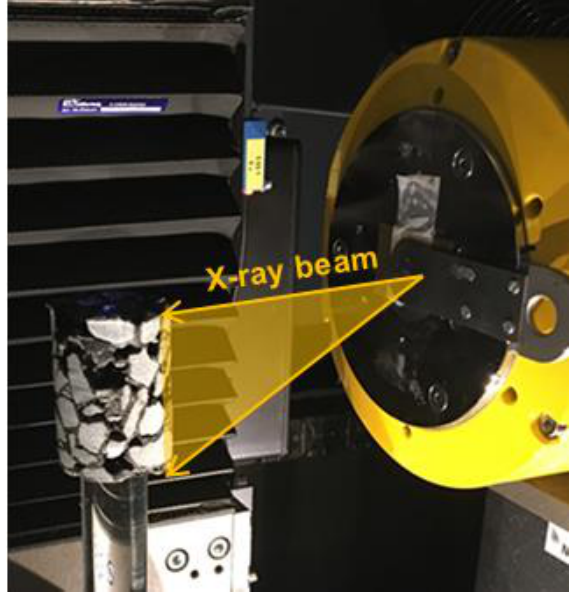
Figure 4. XCT scanning system for porous asphalt specimen.